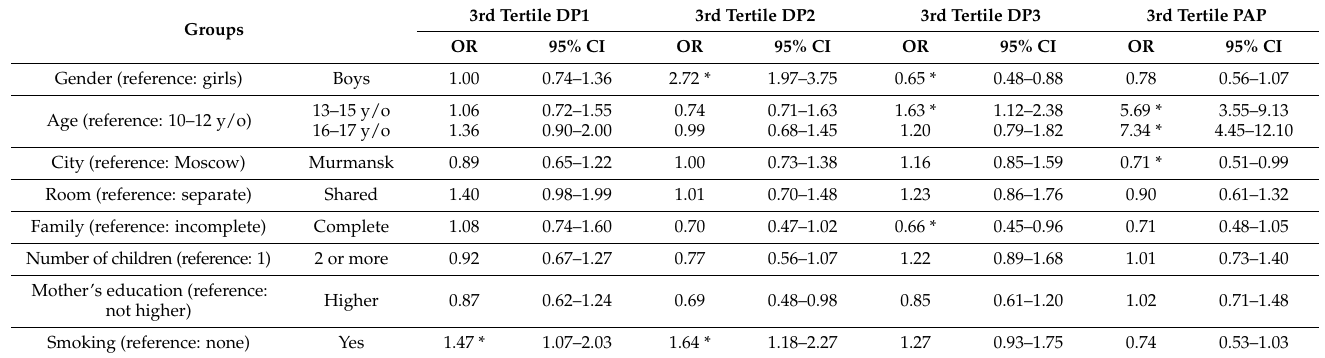
Table 4. Effect of gender, age, area of residence and social conditions on the likelihood of adverse